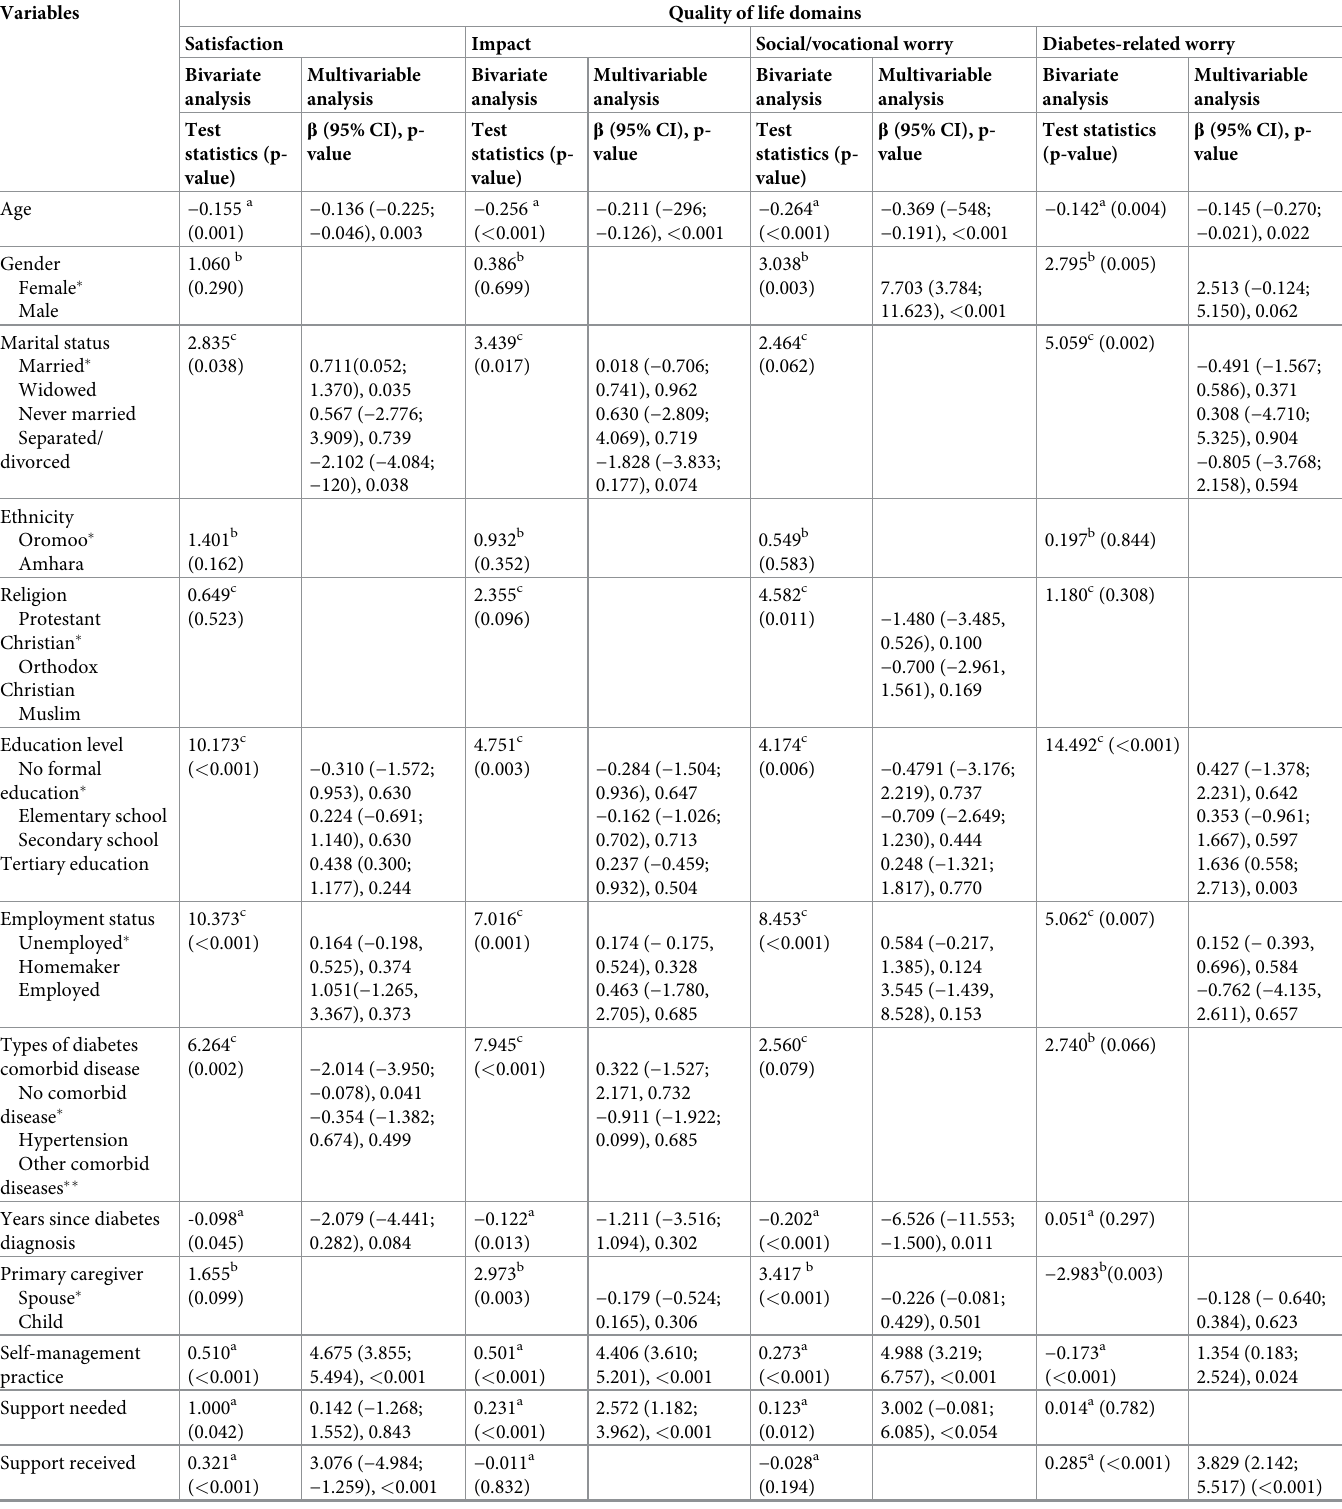
Table 3. Bivariate and multivariable results of variables with QOL